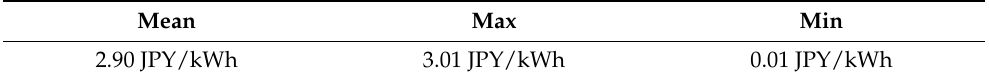
Table 7. Mean, maximum, and minimum values of bid-ask spreads (with the simple market